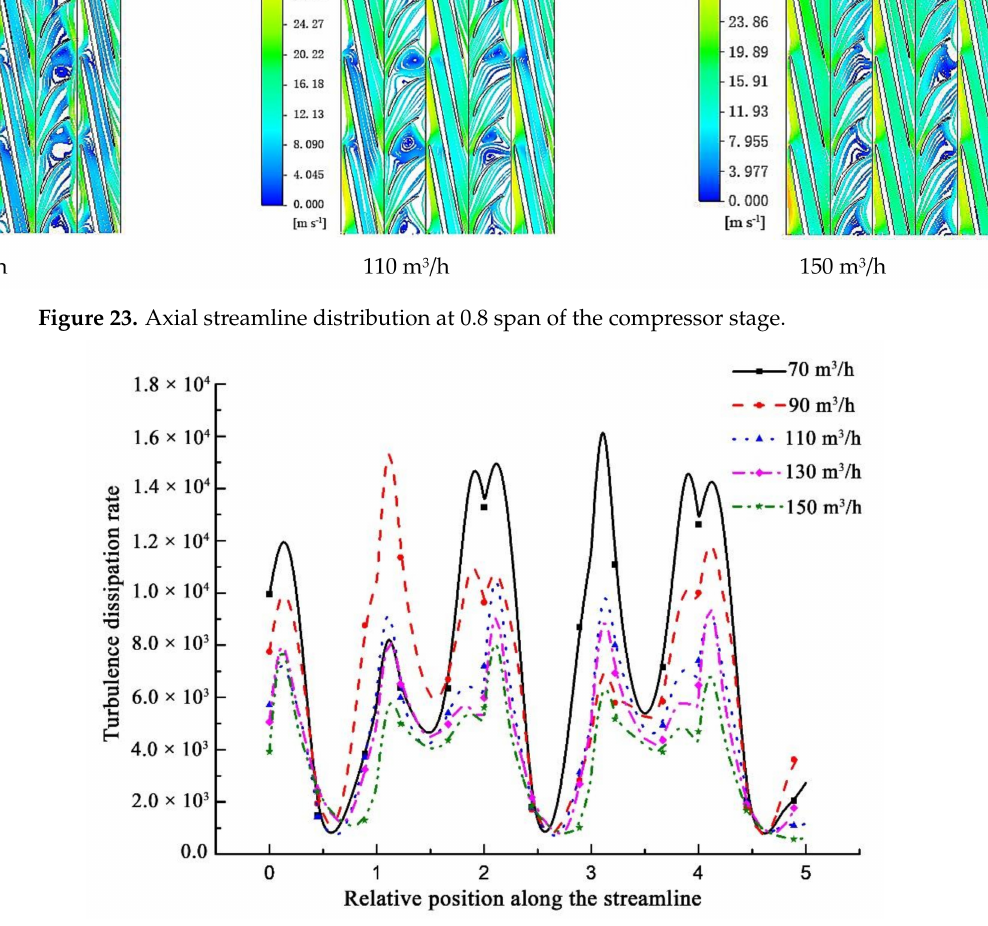
Figure 24. The variation of turbulence dissipation rate from the inlet of the first-stage rotating impeller to the outlet of the last-stage rotating impeller at different flow